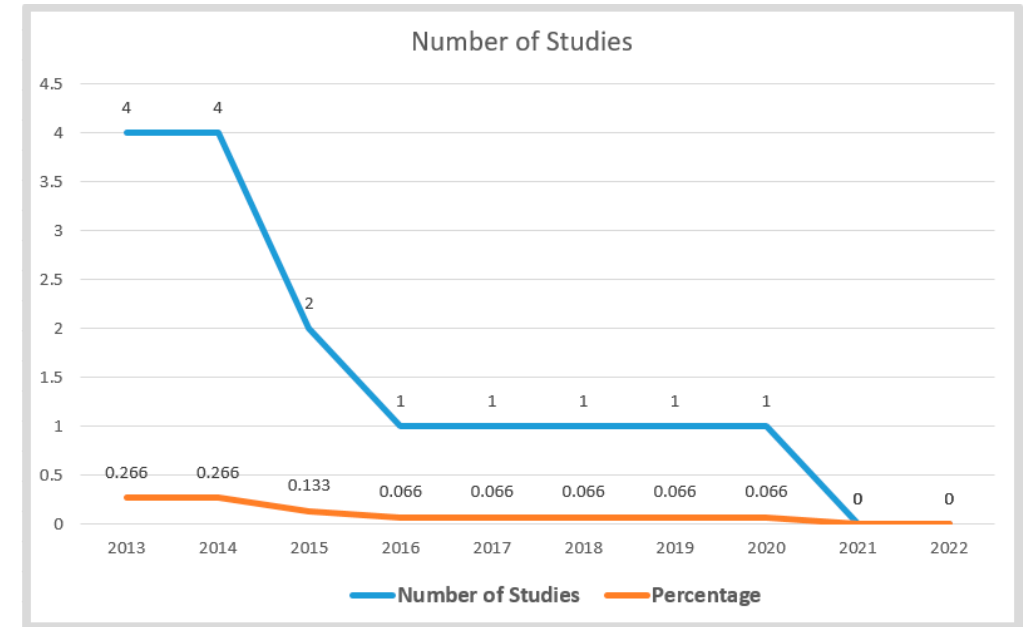
Table 4. Quality assessment score.